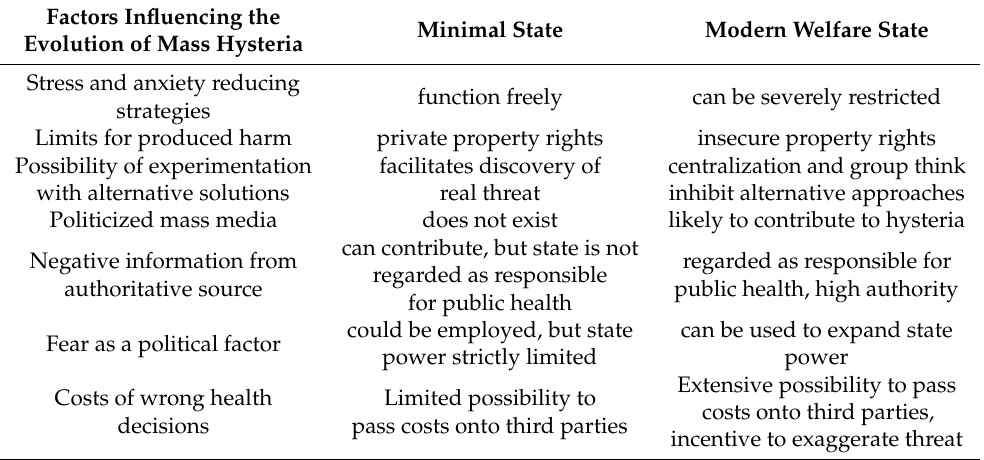
Table 3. The state’s impact on the development of mass